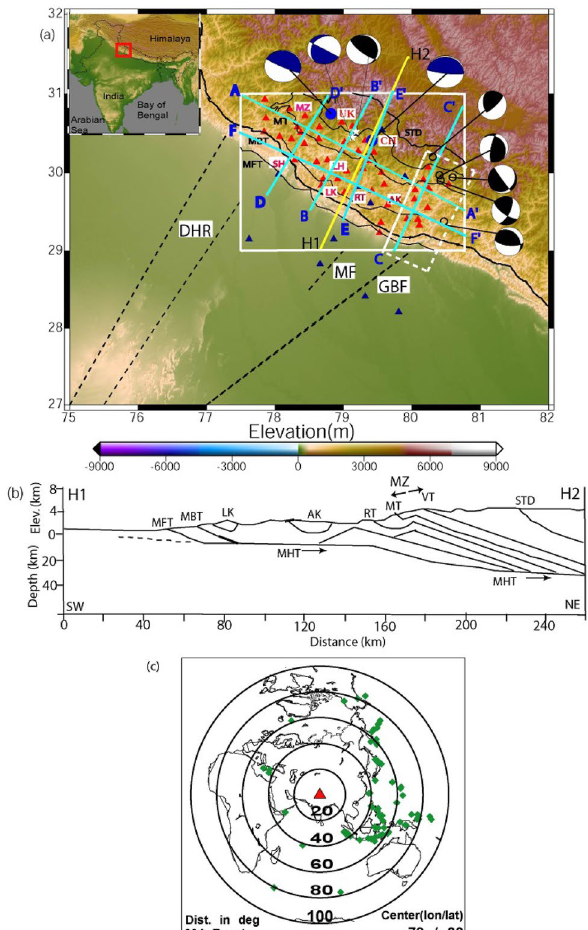
Figure 1. ( a ) Station location map of the Kumaon—Garhwal (KG) Himalayan region. Filled red triangles mark the location of broadband stations while filled dark blue triangles mark the locations broadband stations, which did not provide any data for our study. Two large filled blue circles mark the epicentral locations of the 1991 Uttarkashi and 1999 Chamoli earthquakes. The solid black line represents major faults. MT: Munsiari Thrust; VT: Vaikrita Thrust; MBT: Main Boundary Thrust; MFT: Main Frontal Thrust; RT: Ramgarh Thrust; MHT: Main Himalayan Thrust. SH, LH, AK, LK and MZ mark Siwalik Himalaya, Lesser Himalaya, Almore klippe, Lansdown Klippe and MCT zone, respectively. Dotted black lines mark the inferred northeast-ward extension of Delhi-Haridwar ridge (DHR), Mordabad fault (MF) and Grean Boundary Fault (GBF), respectively. Light blue lines mark the locations of six profiles (AA’, BB’, CC’, DD’, EE’ and FF’) along which 2-D images using CCP stacking are being generated. Figure 2a is generated using the Generic Mapping Tool (GMT) software version 6 62 (https:// doi. org/ 10. 1029/ 2019G C0085 15). Existing focal mechanisms of Uttarakhand earthquakes are also shown. A white dotted box shows the region with strike-slip mechanisms (Hajra et al., 2021). The elevation data used in generating GMT plot is obtained from the open source Digital Elevation Model (DEM) (https:// aster web. jpl. nasa. gov/ gdem. asp), ( b ) Tectonic depth cross-Sect. 1 across the NE-SW H1H2 profile, whose location is shown by yellow line in Fig. 2( a ) and ( c ) Epicentral plot of 200 teleseismic events, whose broadband data from the Uttarakhand network, are used for our P-receiver function study. A red triangle and green diamond symbols mark the center of our network (Lat. 79°, Long. 30°) and epicenters of selected teleseismic